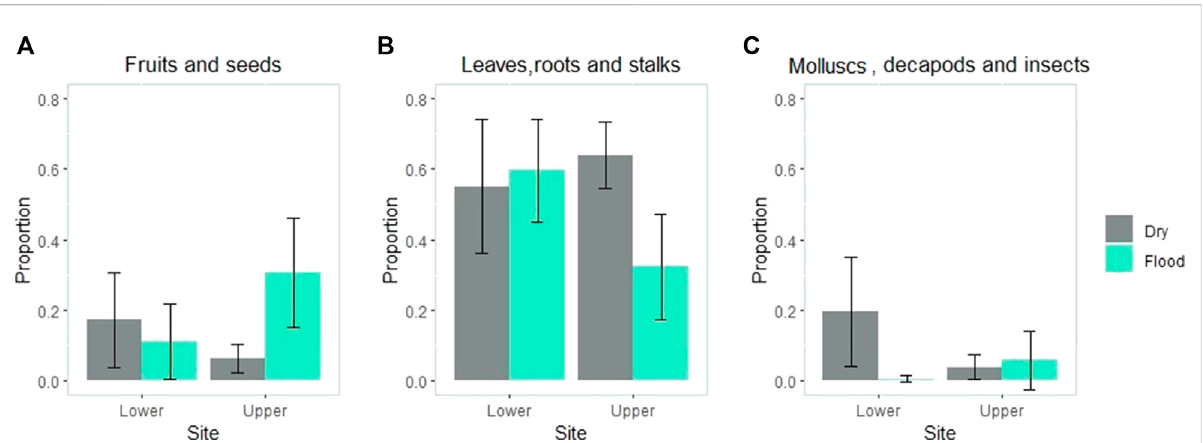
FIGURE 1 Volumetric proportion of items grouped into functional categories (A) fruit and seeds (B) roots, stalks and leaves; (C) molluscs, decapods and insects) consumed per site and season (blue = wet season; gray = dry season). Although we used a permutational ANOVA, mean values and 95% intervals of con fi dence bars are shown for